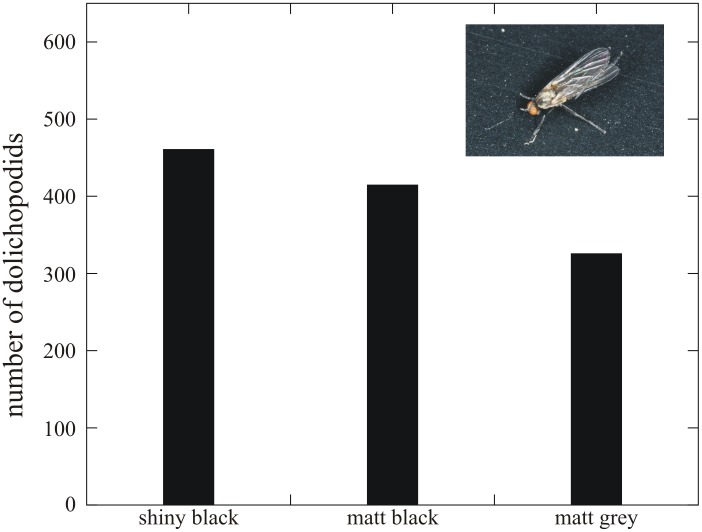
Total numbers of dolichopodids landed on the shiny black, matt black and matt grey horizontal test surfaces in experiment 1.The inset is a photograph of a dolichopodid fly landed on the matt black test surface. The number of repetition is 6 (see Materials and methods, and Discussion).